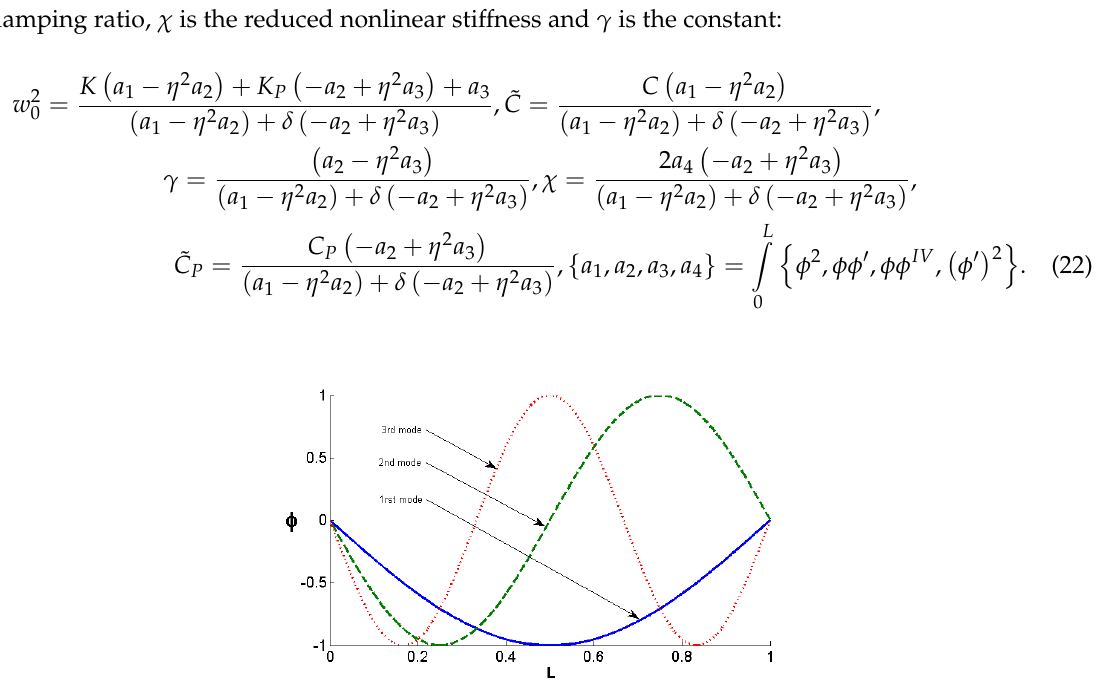
Figure 2. First three vibration mode shapes for the simple-simple case boundary